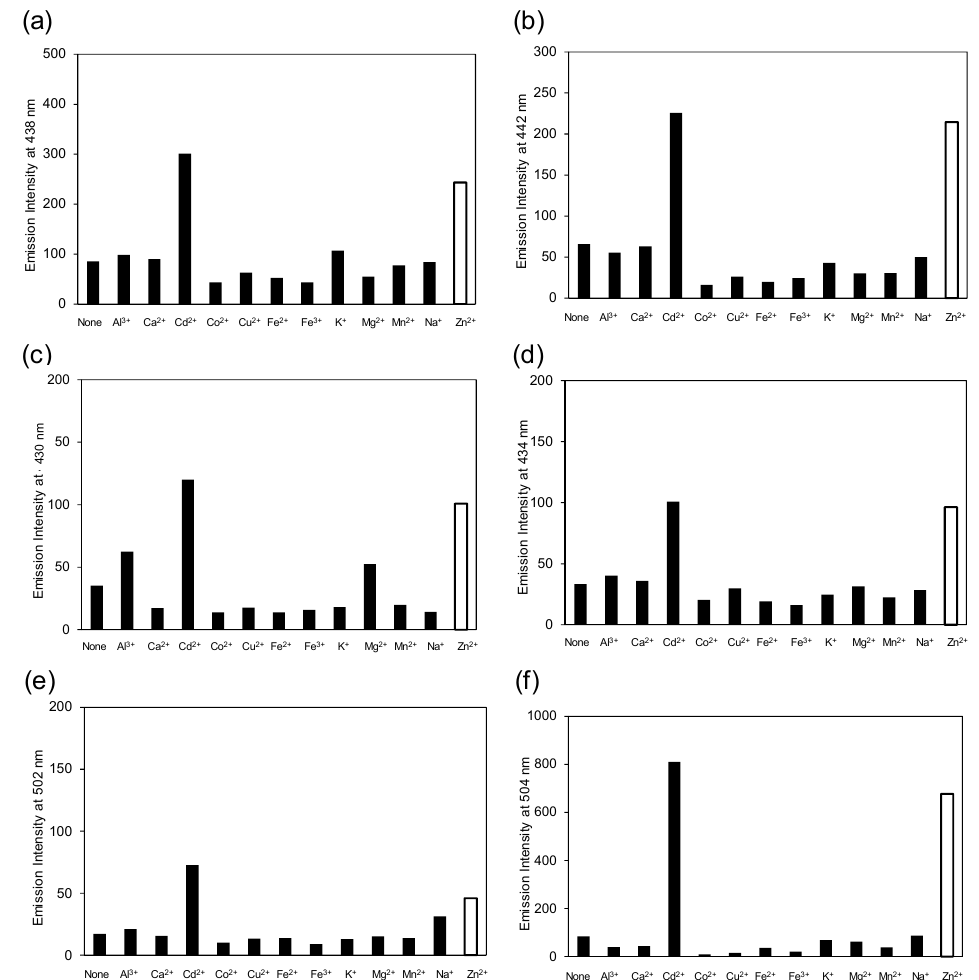
Figure 3. Fluorescence responses of ( a ) 3a (10 − 5 M, λ em = 381 nm); ( b ) 3b (10 − 5 M, λ em = 367 nm); ( c ) 4a (10 − 5 M, λ em = 353 nm); ( d ) 4b (10 − 5 M, λ em = 360 nm); ( e ) 5a (10 − 5 M, λ em = 377 nm); ( f ) 5b (10 − 5 M, λ em = 395 nm) upon addition of di ff erent metal cations in HEPES bu ff er (100 mM, 5% DMSO, pH = 7.4). λ em = emission wavelength.